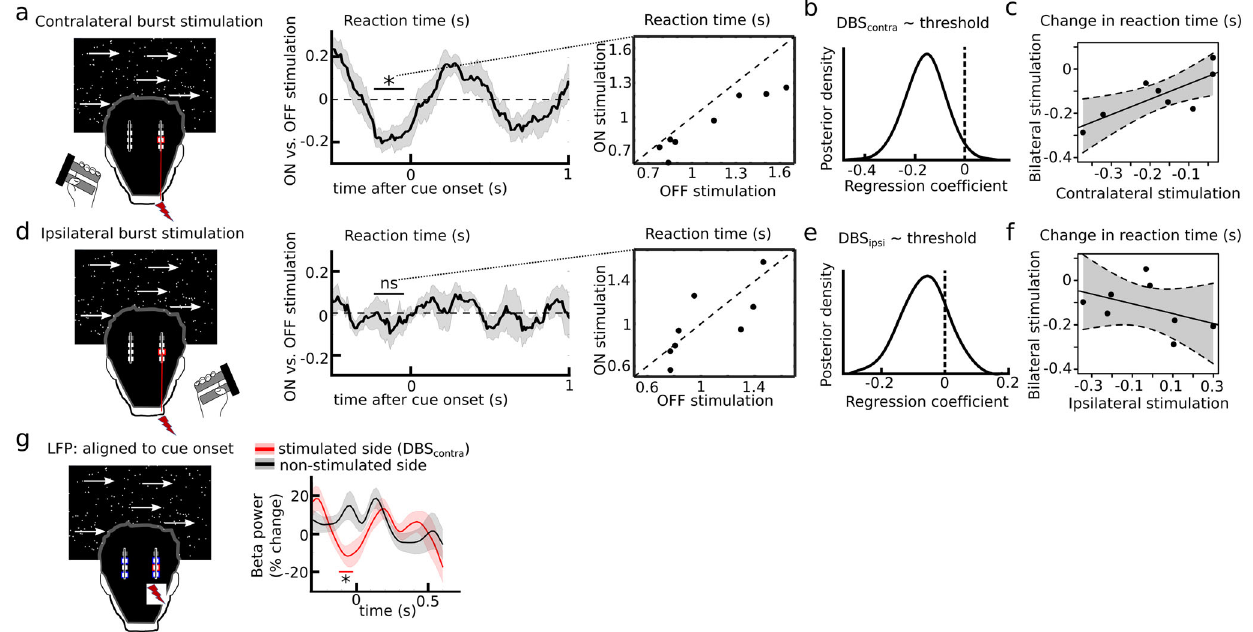
Fig. 6 | Unilateralstimulation. a Trialsweredivided into contralateralstimulation (e.g., left-handed response during stimulation of right STN) and ipsilateral stimu- lation (e.g., right-handed response during stimulation of right STN, shown in D ). Contralateralstimulationreducedreactiontimesinatimewindowfrom230 – 40ms pre cue (compare to Fig. 4C). Single participant ( n =8) responses for this time window (DBS contra ) are shown in the right panel. B DBS contra signi fi cantly reduced decisionthresholds. C Acrosssubjects( n =8),thebehavioraleffectofcontralateral stimulation on reaction times predicted the effects of bilateral stimulation on reaction time changes (predicting ~67% variance, regression slope illustrated by black line, 95% CI shown by dotted lines). D During ipsilateral stimulation no sig- ni fi cant effects on reaction times were observed across subjects ( n =8, corrected